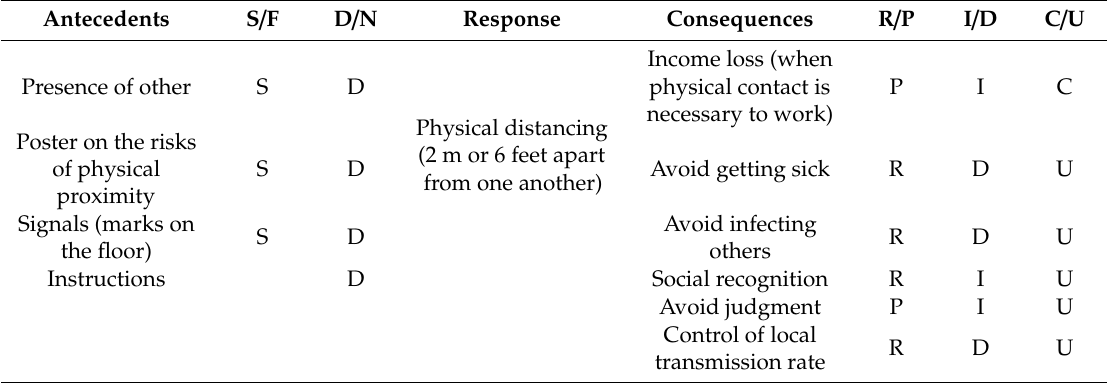
Table 1. Functional analysis of physical distancing with ratings inspired by the PIC / NIC Analysis tool and stimulus